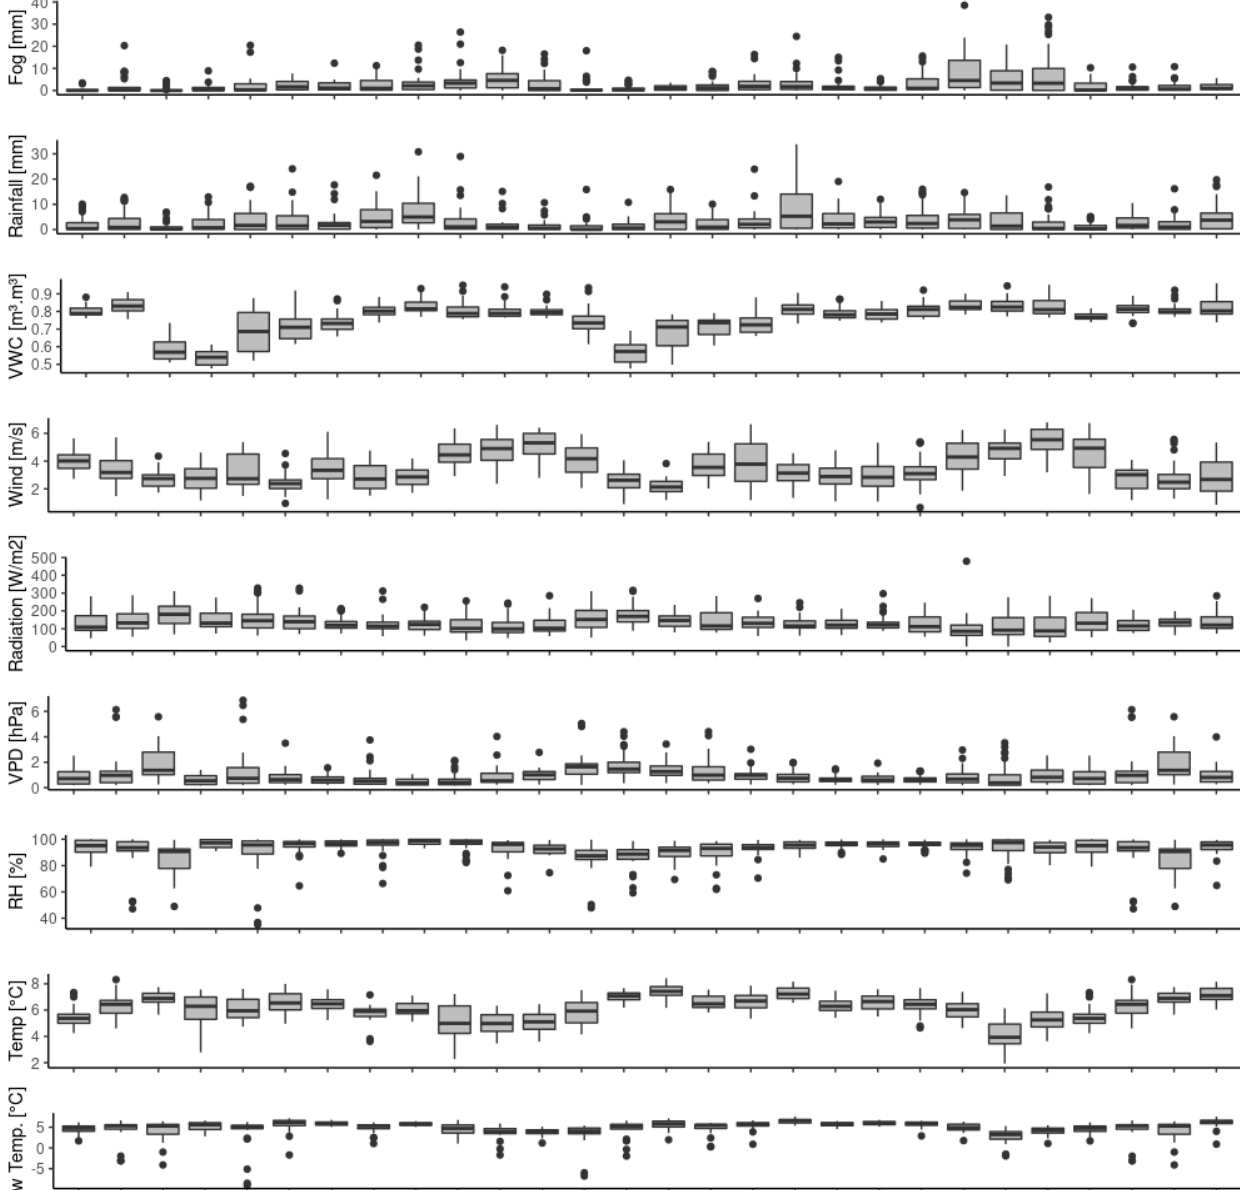
Figure 2. Fog input, precipitation, volumetric water content ( VWC ), and meteorological variables for the study site during September 2017 to December